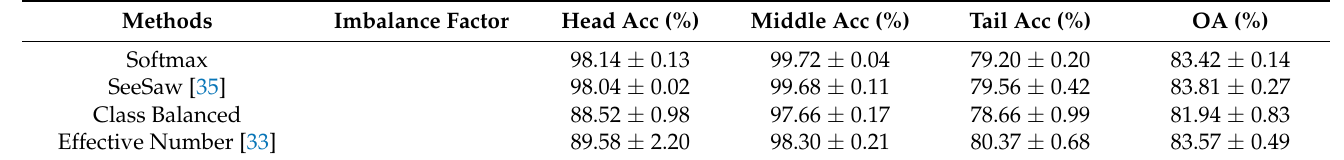
Table 5. Comparison results of the proposed method with other similar advanced methods on the long-tailed PatternNet dataset with imbalance factors of 0.005, 0.01, and